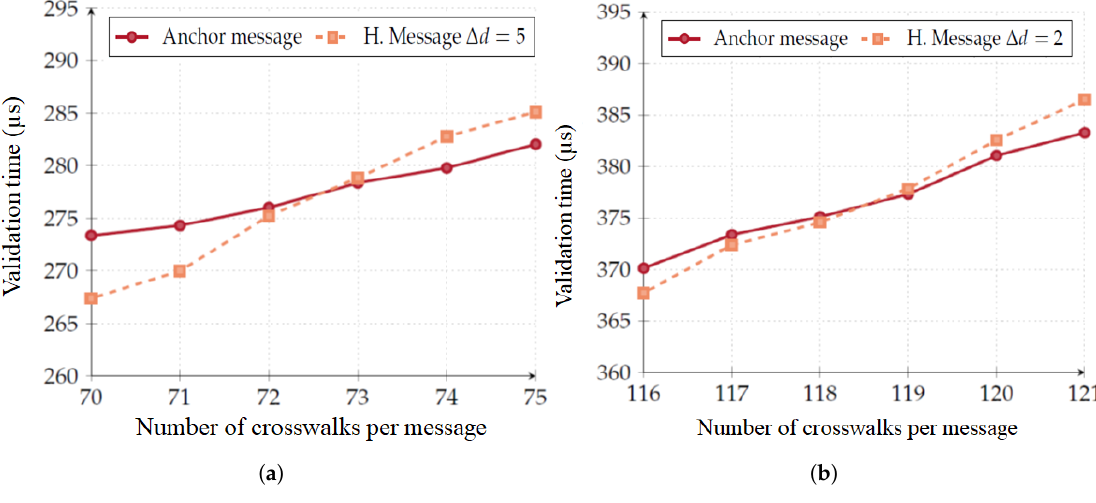
Figure 10. Comparison of anchor message validation against implicit message validation. ( a ) 73 crosswalks and five validity intervals. ( b ) 119 crosswalks and two validity